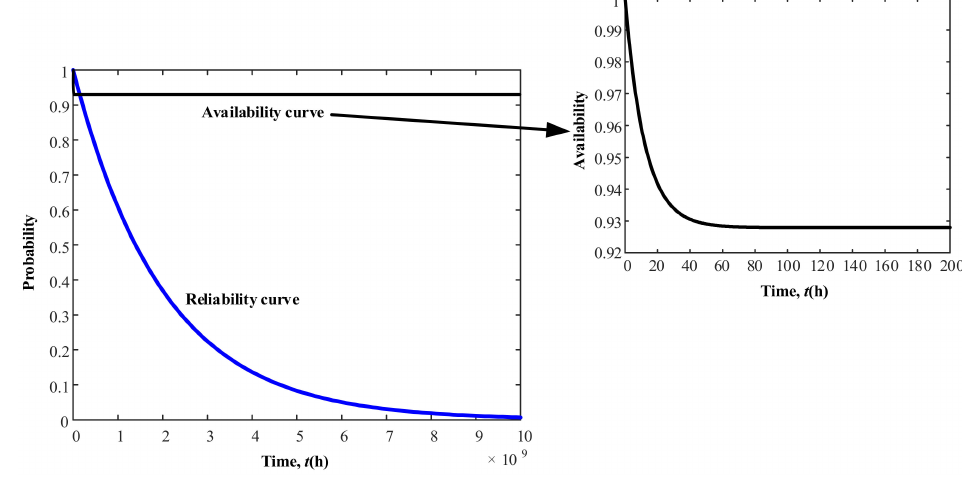
Figure 9. Reliability and transient availability of subsea wellhead